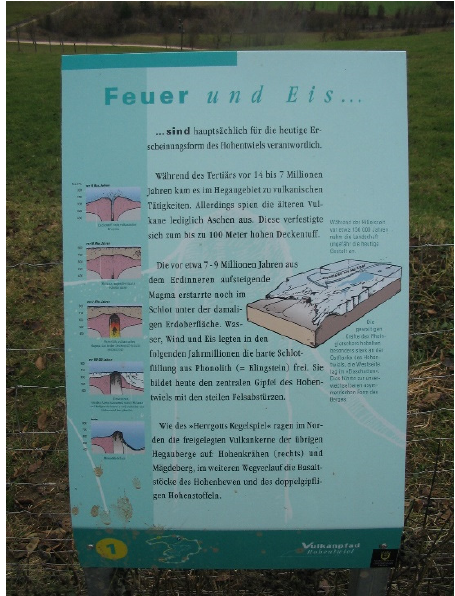
Figure 11. Well-designed panel with little text, different text levels and descriptive graphics. Volcano Trail Hohentwiel (Germany) (Megerle 2007).